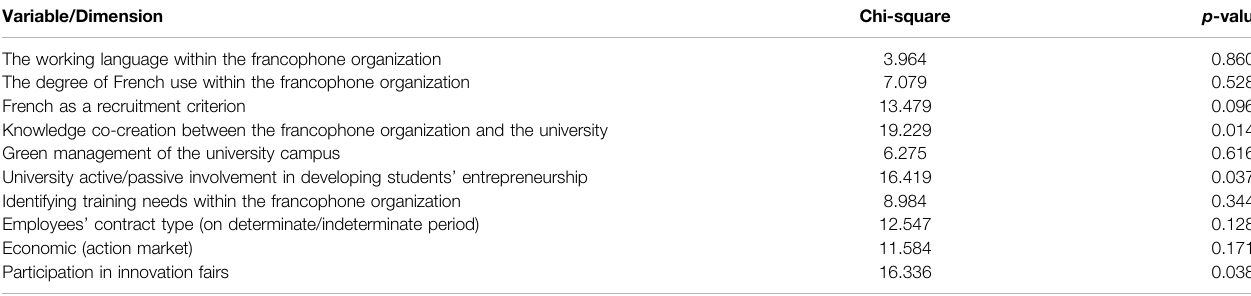
TABLE 3 | The Marginal Homogeneity test for francophone organizations.